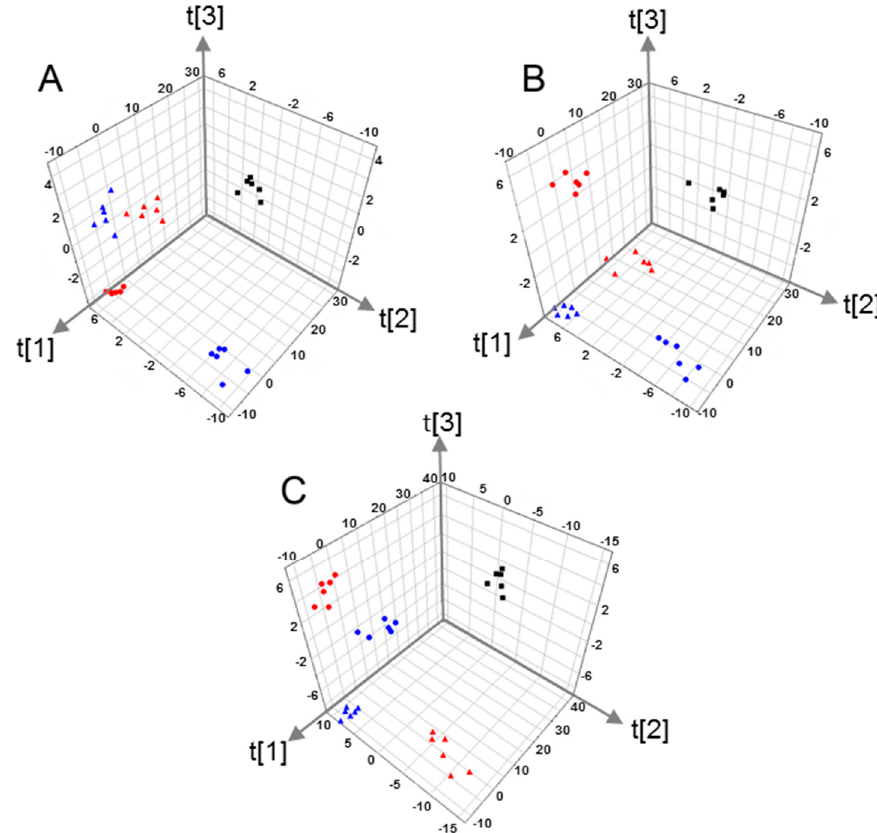
Figure 3. The PLS-DA score plots based on QTOF data sets of MCF-7 cells treated with different concentration of metalaxyl enantiomers. ■ Control, ▲ S -metalaxyl (10 µM), ▲ S -metalaxyl (50 µM), ● R -metalaxyl (10 µM), ● R -metalaxyl (50 µM). ( A ) Positive mode, ( R 2 X = 0.829, R 2 Y = 0.982, Q 2 =